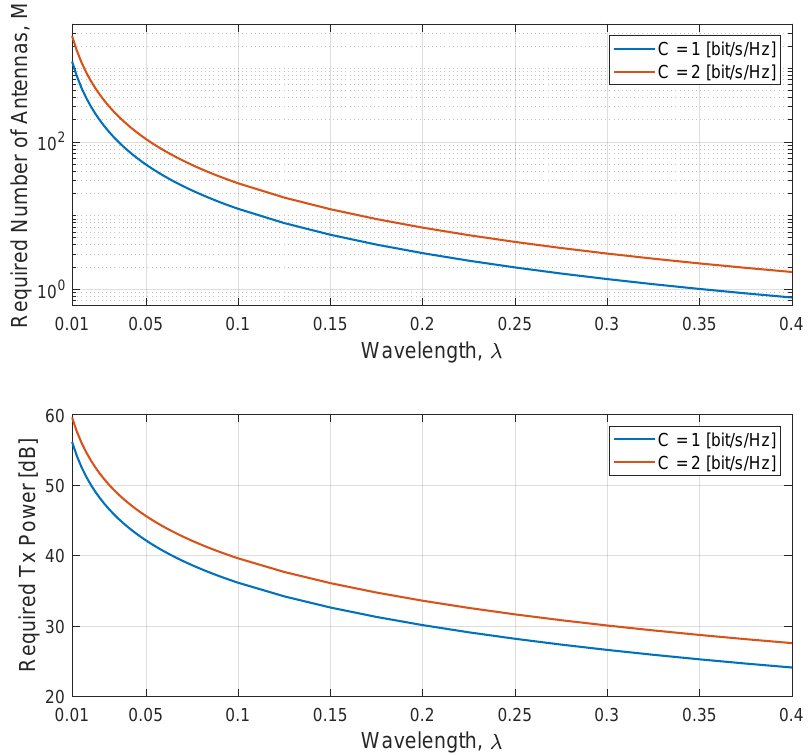
Figure 12. Required number of antennas and Tx power versus the wavelength, λ